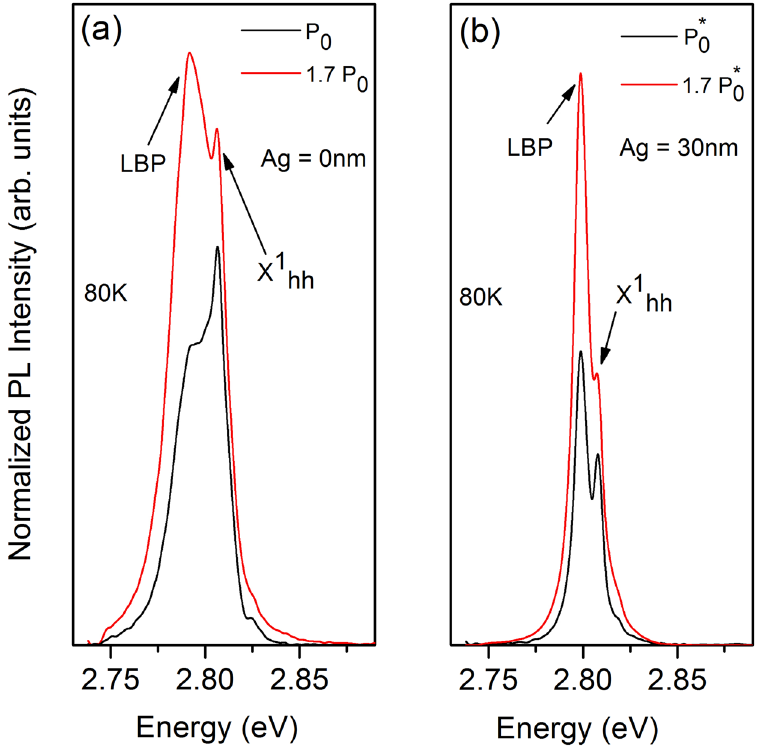
Figure 7. Emission spectra ( θ = 0°) of the unfolded MC structure without Ag ( a ) and with Ag ( b ) for different excitation powers at T = 80